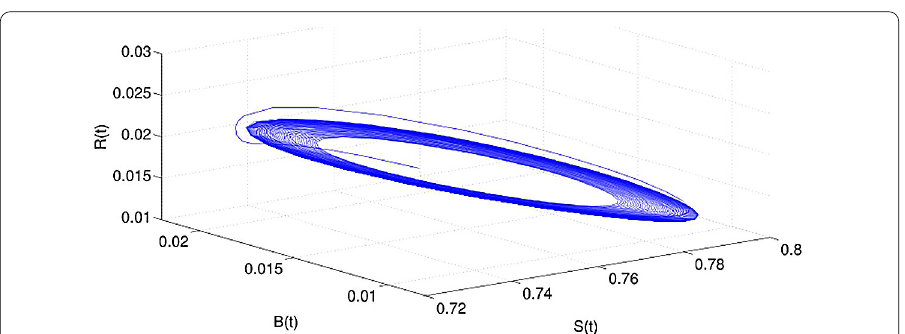
Figure 6 Dynamic behavior of system (41): projection on S-B-R with τ =